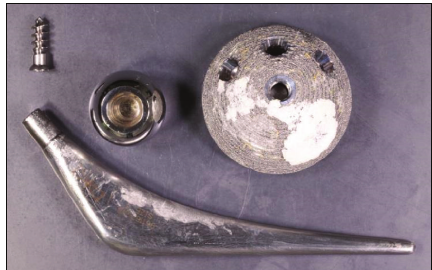
Figure 1: Retrieved components from the original total hip arthro- plasty.